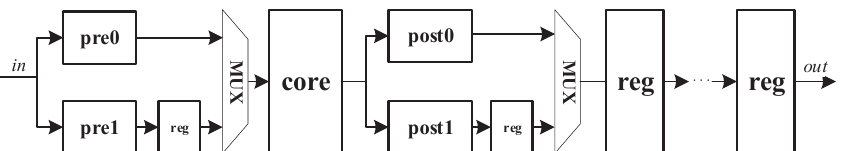
Figure 12. Optimizing the pipeline architecture of the hardware, where pre represents the preprocess- ing module, core represents the core computing unit, post represents the postprocessing module, reg represents the register, Mux represents multiplexers.